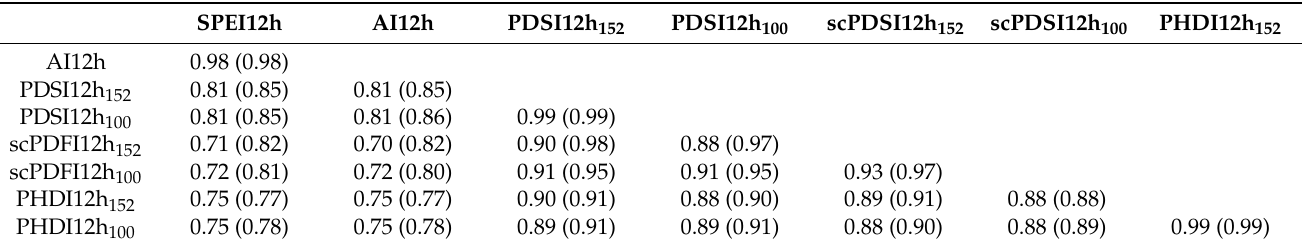
Table 2. Correlation coefficients between drought indices as parameterized by on-site and PRISM (in parentheses).